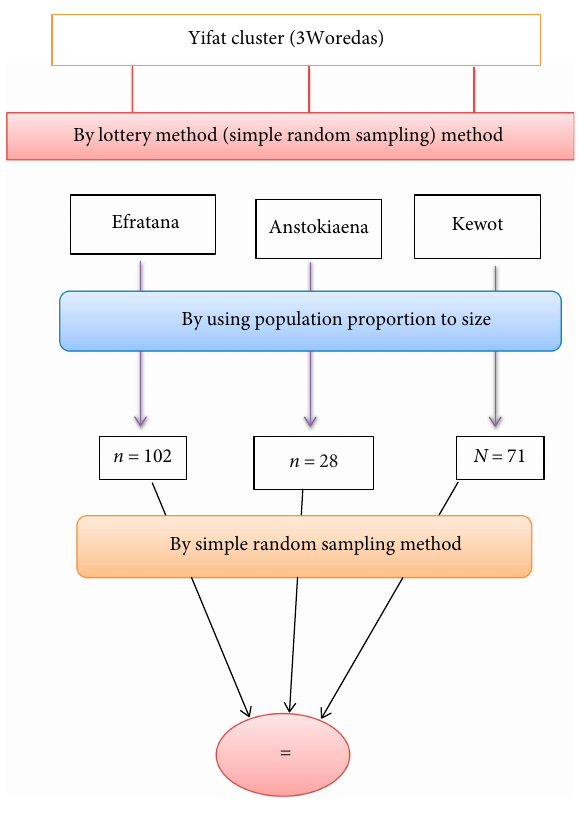
Figure 2: Schematic representation of sampling procedure on implementation of IMNCI among health care professional in North Shewa zone, Ethiopia,